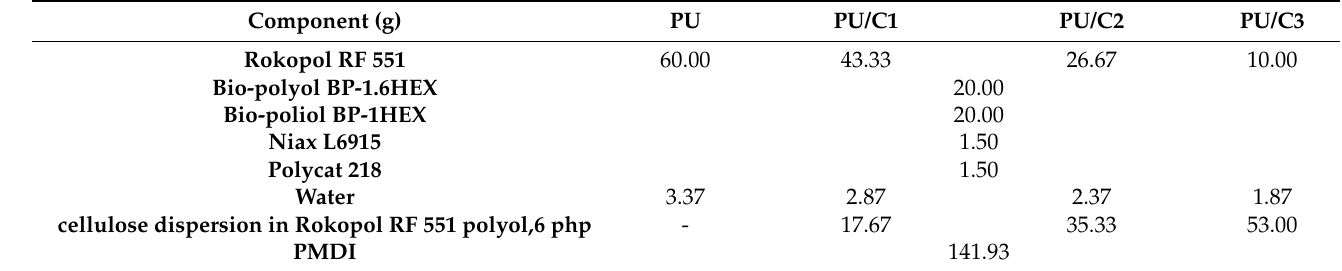
Table 2. Polyurethane systems with